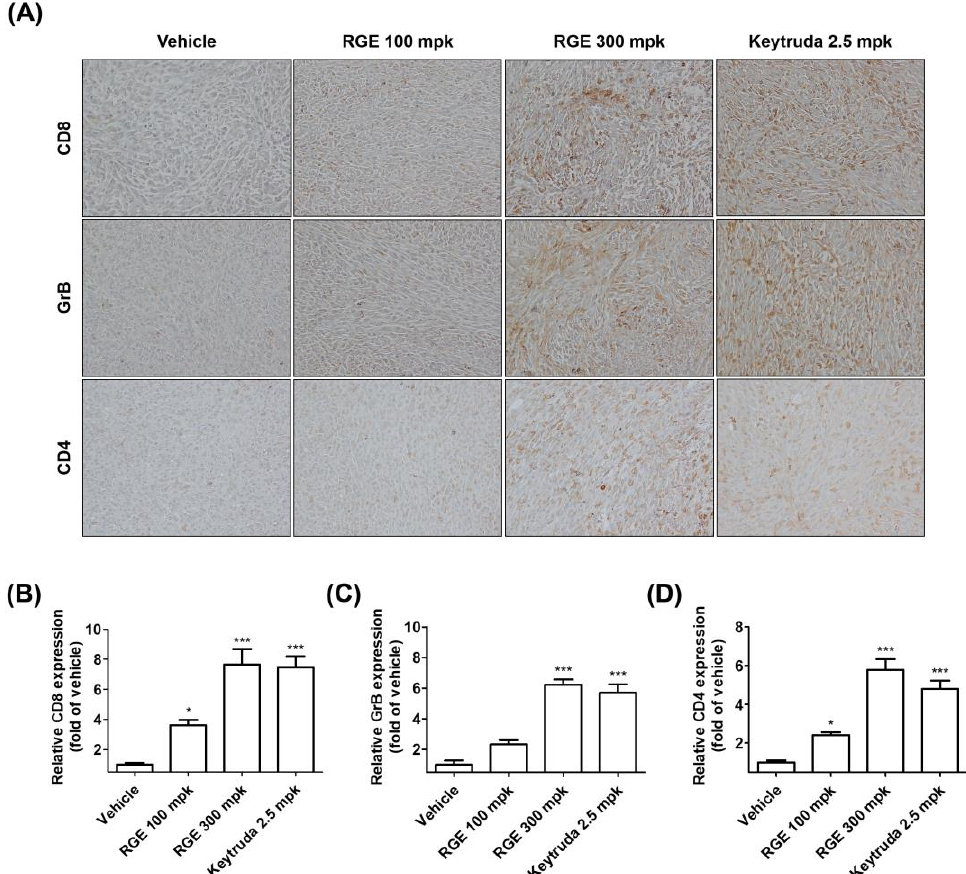
Figure 4. RGE activates hPD-1 tumor-infiltrating CD8 + T cells in vivo by immunohistochemical staining. ( A ) Representative images ( × 400) of CD8 + , GrB, and CD4 + staining of tumor tissues by immunohistochemical analysis. ( B – D ) Quantification of CD8 + ( B ), GrB ( C ), and CD4 + ( D ) expression in tumor tissues. Data are presented as the mean ± SD, * p < 0.05, *** p < 0.001 compared with the control.